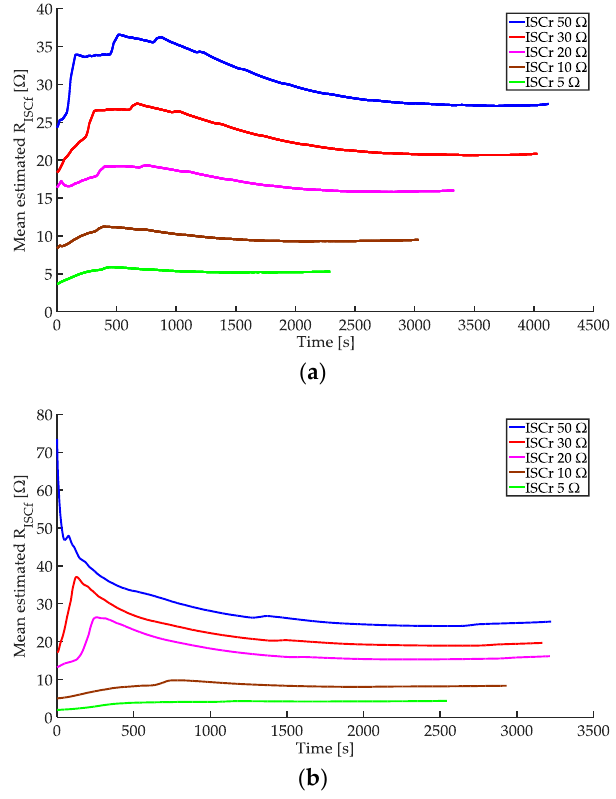
Figure 10. 𝑅 𝐼𝑆𝐶𝑓 ̅̅̅̅̅̅̅ in the experiment with cell A with ISCr 50, 30, 20, 10 and 5 Ω: ( a ) DST 5 A; ( b ) UDDS 5